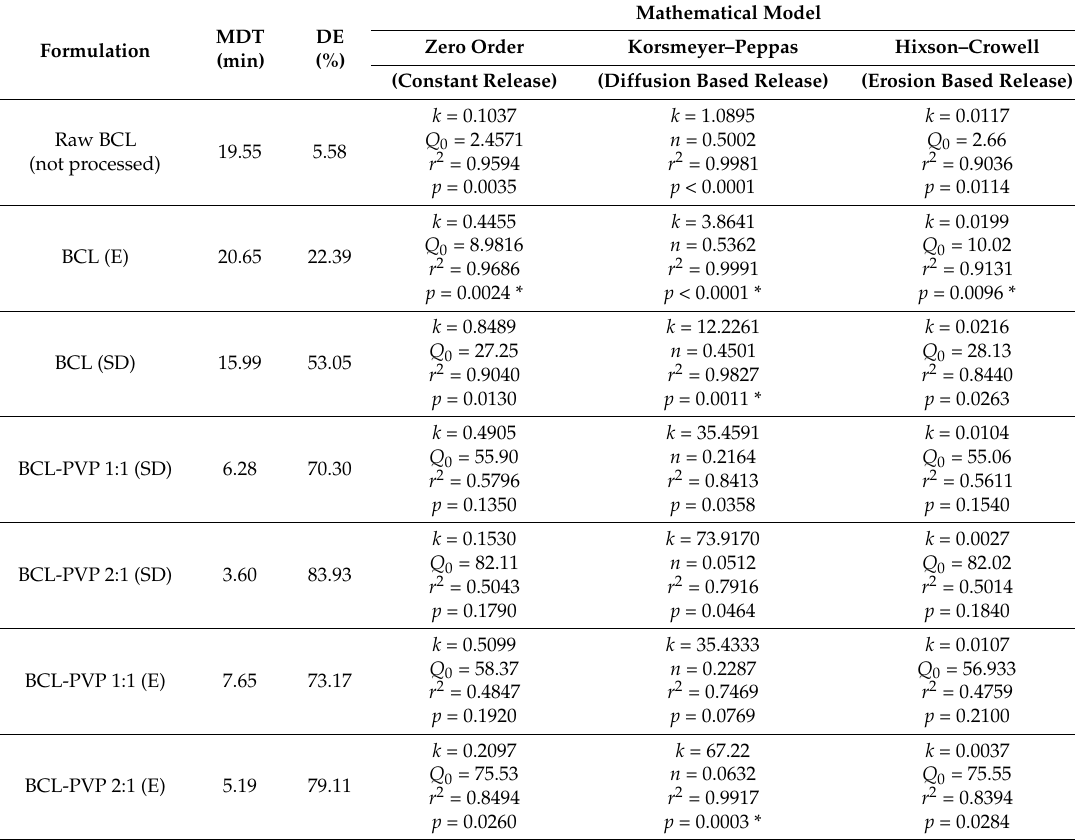
Table 5. Parameters, determination coefficients and statistical significance of dissolution kinetics